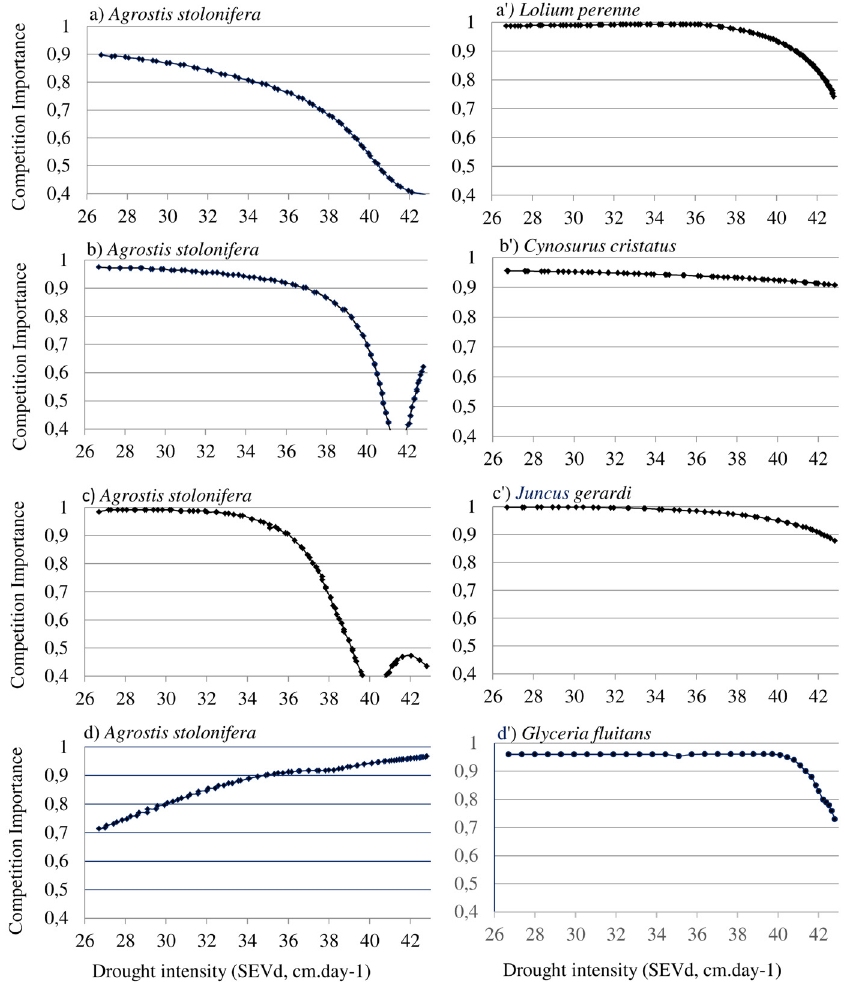
Fig 3. Importance of competition calculated for each group of species along the drought gradient, with an initial cover of species, i, j and k: 1, 1, 0. Competition importance represents the proportion of change in ecological success caused by competition relative to environmental conditions. The SEVd was calculated following [11] and expressed as cm.day-1. The Fig 3 (a, b, c, d) report the results for Agrostis stolonifera modeled in pair with respectively Lolium perenne , Cynosurus cristatus , Juncus gerardi , Glyceria fluitans . Results for Lolium perenne are reported in Fig 3a ’ , for Cynosurus cristatus in Fig 3b ’ , for Juncus gerardi in Fig 3c ’ and for Glyceria fluitans in Fig 3d ’